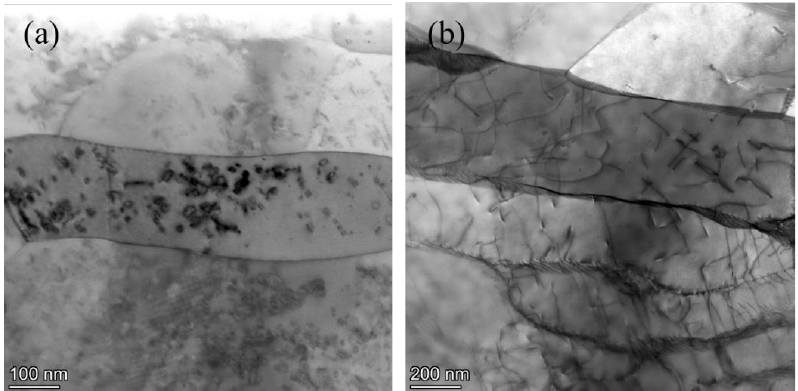
Figure 8. STEM-BF images showing thin, elongated subgrains: ( a ) Fe-9Cr-C irradiated at 450°C; ( b ) Fe-9Cr-C irradiated at 550°C.